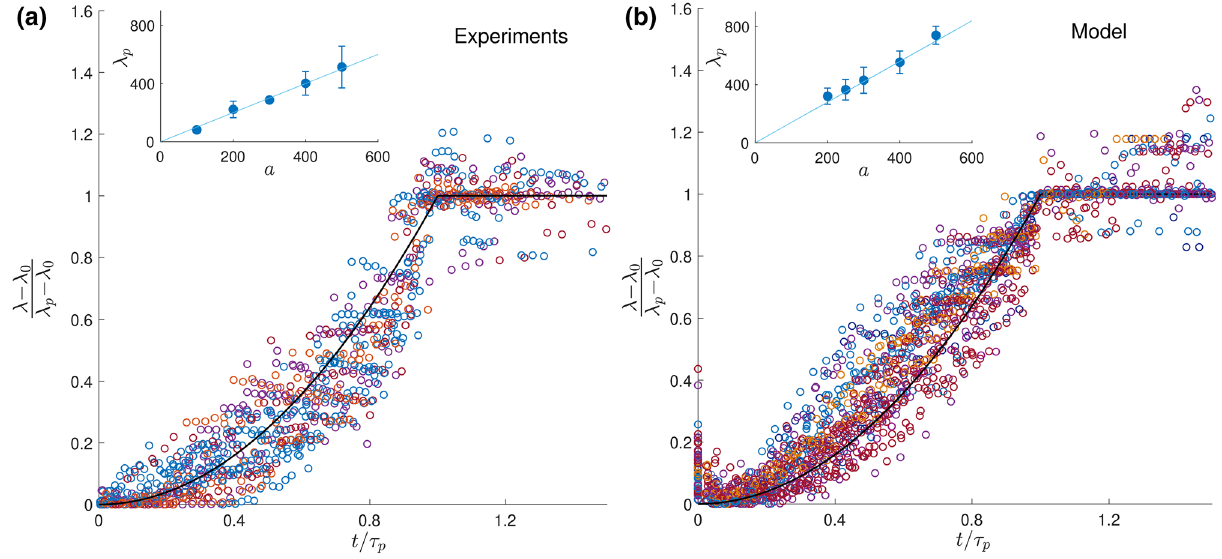
Figure 2. Time evolution of the wavelength in experiments ( a ) and model ( b ). In both cases, the wavelength (cid:31) is rescaled using its initial ( (cid:31) 0 ) and final values ( (cid:31) p ) and is plotted as a function of the reduced time, t /τ p , where τ p is the time at which (cid:31) plateaus. Colours correspond to different confinement sizes. The black line is y = x 2 for x < 1 and y = 1 after. Insets show final wavelengths scaling linearly with channel size, with error bars showing standard